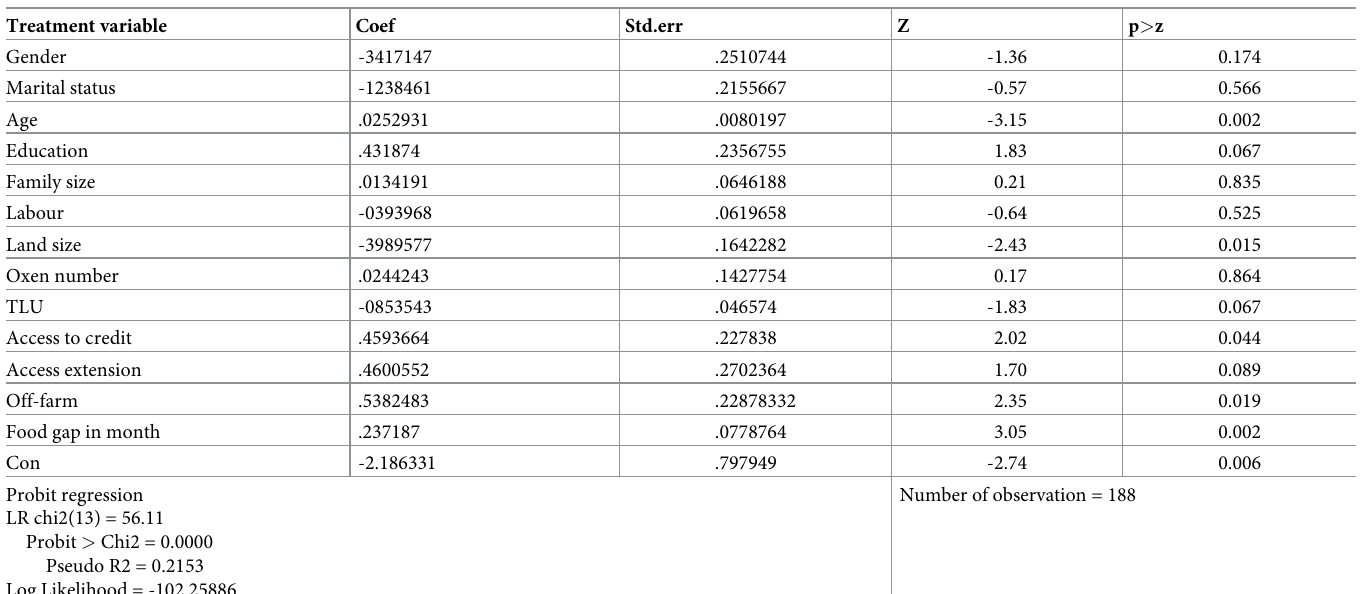
Table 6. Estimation of propensity score through a probit regression